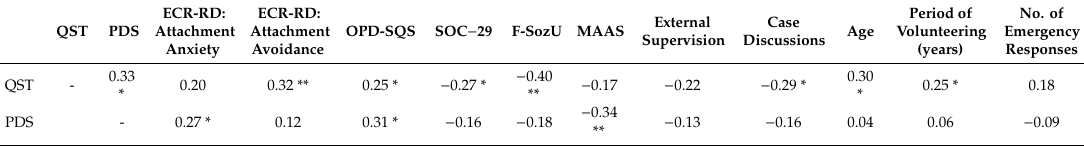
Table 4. Pearson’s correlations between traumatization and factors of resilience of volunteers in psychosocial emergency care. ECR-RD: QST PDS Attachment